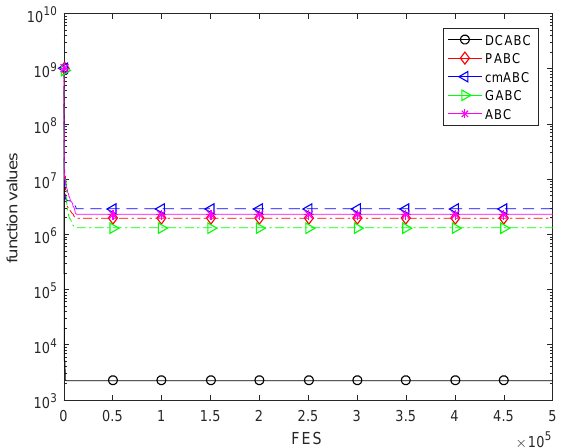
Figure 6. Convergence curves of five algorithms for f 8 with D = 50. (The optimal value of f 8 is 800).